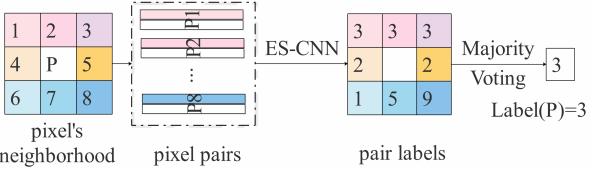
Figure 2. An example of voting strategy within a 3 × 3